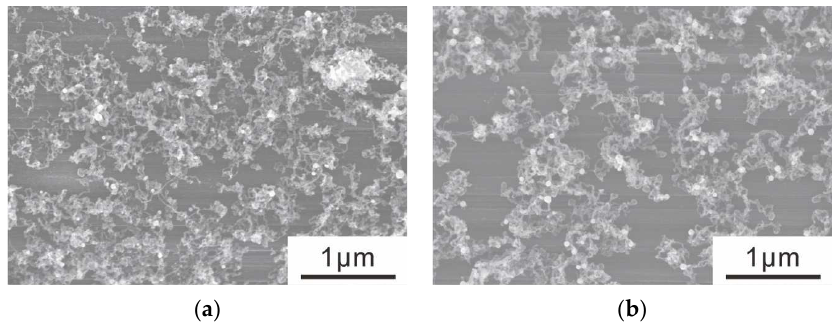
Figure 16. Enlarged FE-SEM images of ( a ) D-CNT 10 -CF and ( b ) P-CNT 10 -CF.